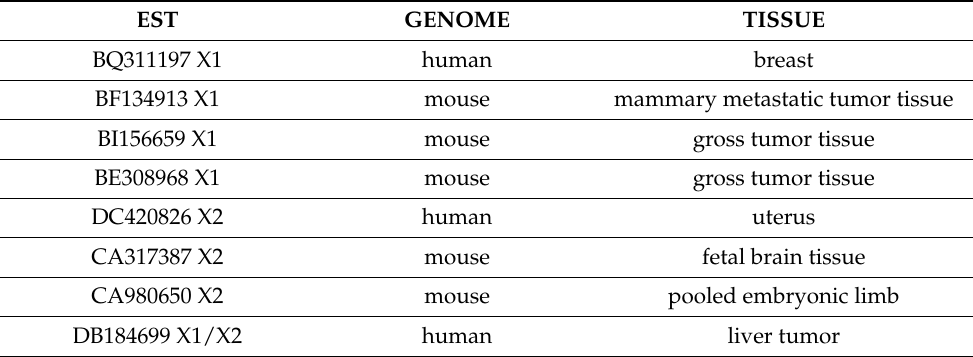
Spliced Expressed Sequence Tags (ESTs) that contain RIOK3 X1 and X2 variant splice junctions.